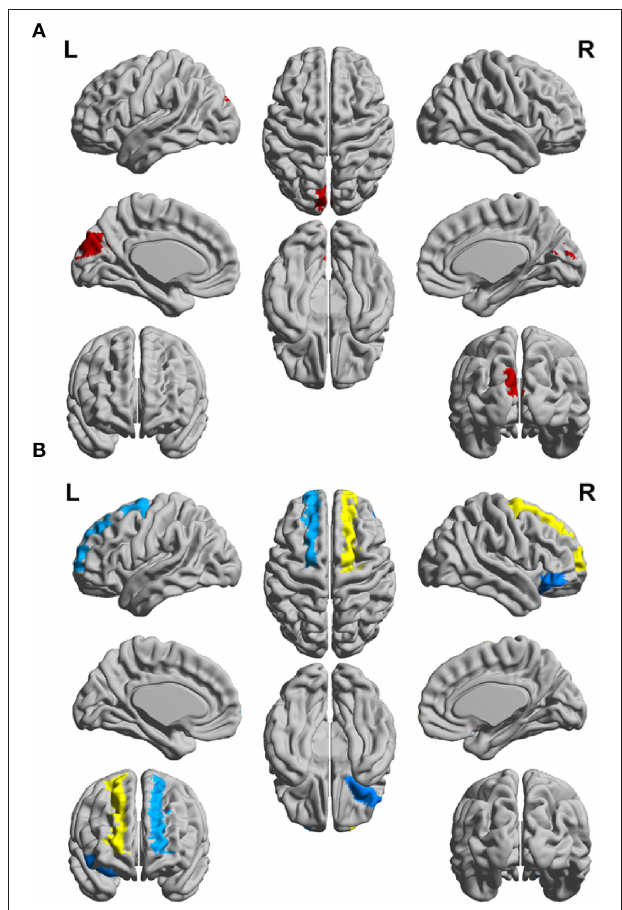
FIGURE 4 | Schematic representation of differences between the CIS and RRMS patient groups for clustering coefficient (CC) of (A) the white matter networks and (B) gray matter networks of the left (L) and right (R)